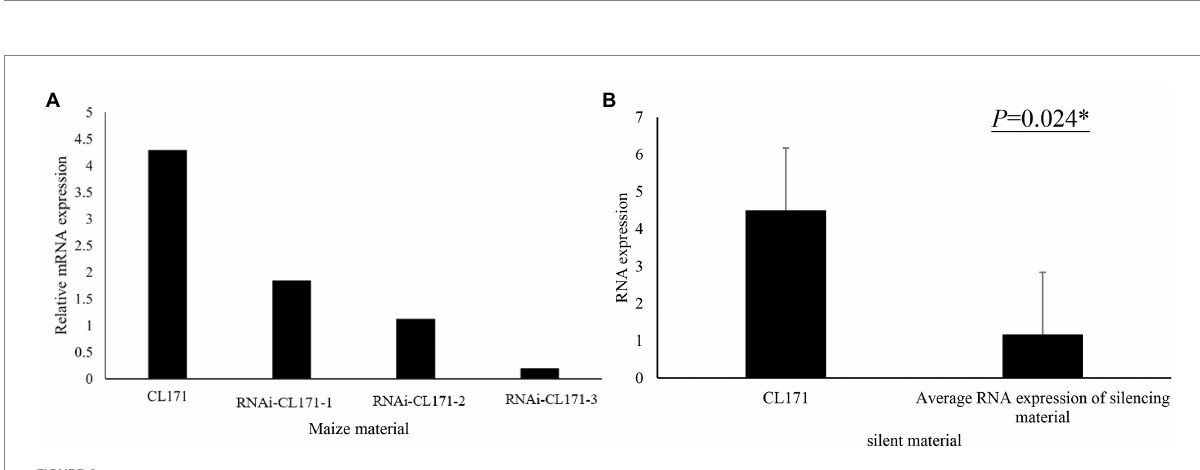
FIGURE 4 (A) Expression of GRMZM2G017792 in CL171 and gene-silenced materials. (B) Significant difference ( p = 0.024) in the RNA expression between CL171 and the gene-silenced materials